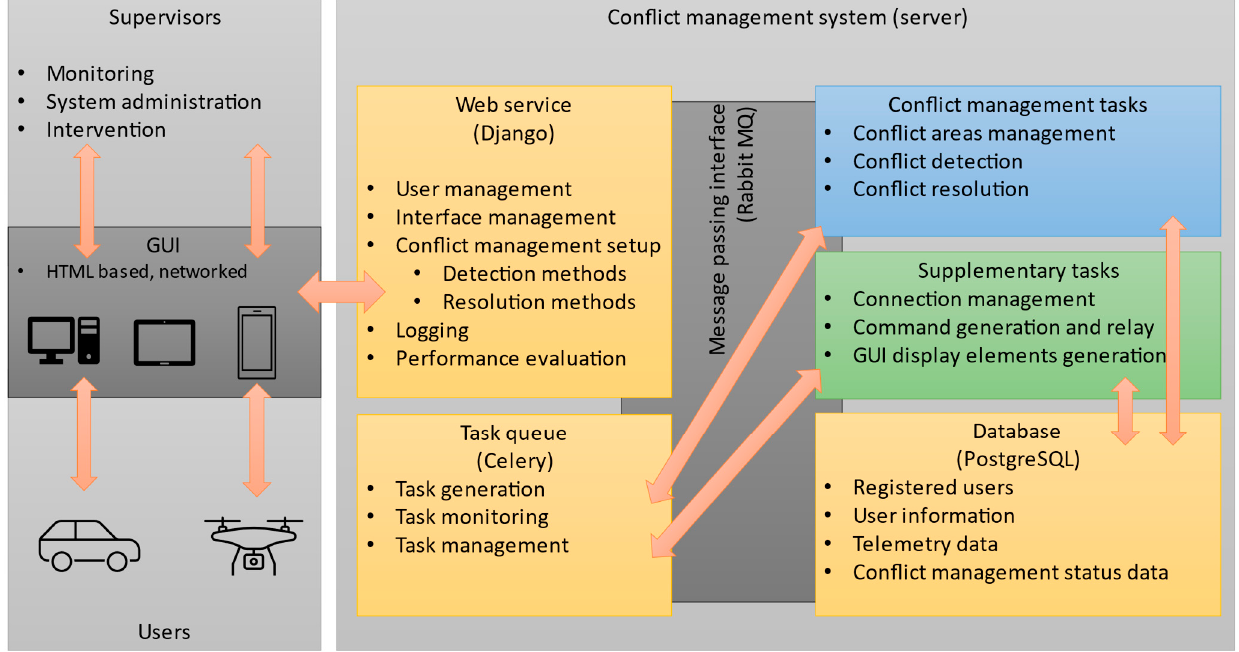
Figure 8. Conflict management system architecture—second version.